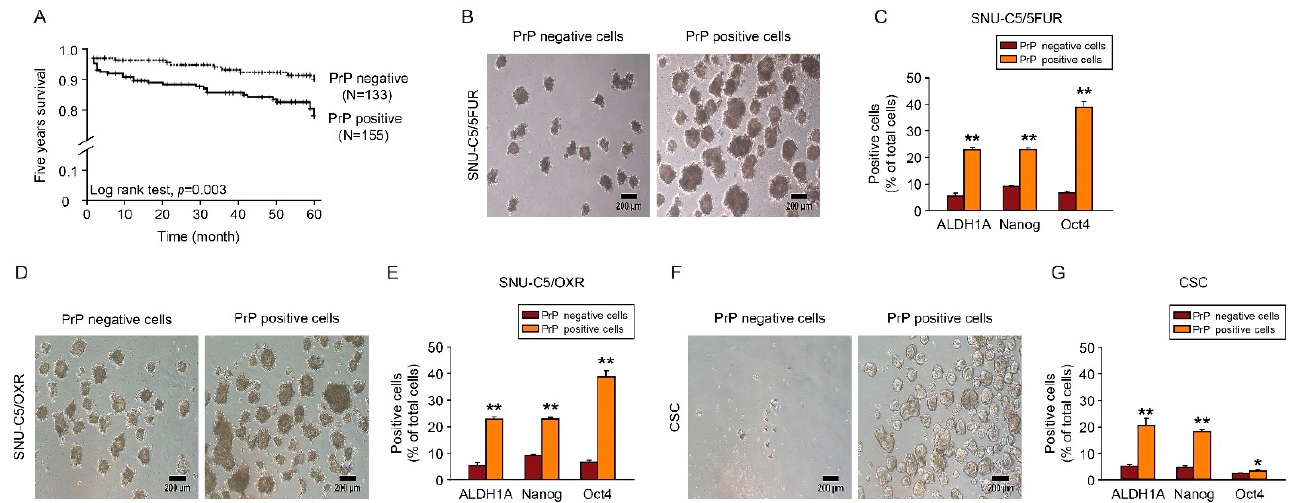
Figure 1. Effect of PrP C of cancer stemness in CRC cells. ( A ) Five-year survival of CRC patients depending on PrP C expression (negative, n = 133; positive, n = 155). ( B – G ) Sphere formation assay of PrP-negative and PrP-positive SNU-C5/5FUR ( B , C ), SNU-C5/OXR ( D , E ), and CSC ( F , G ) in ultra-low attachment plates for 2 weeks (n = 3). Cancer stem cell markers (ALDH1A, Nanog, and Oct4) were analyzed using flow cytometry analysis (n = 3). Scale bar = 200 µ m. Data are represented as the mean ± SEM. * p < 0.05, ** p < 0.01 (unpaired t -test).